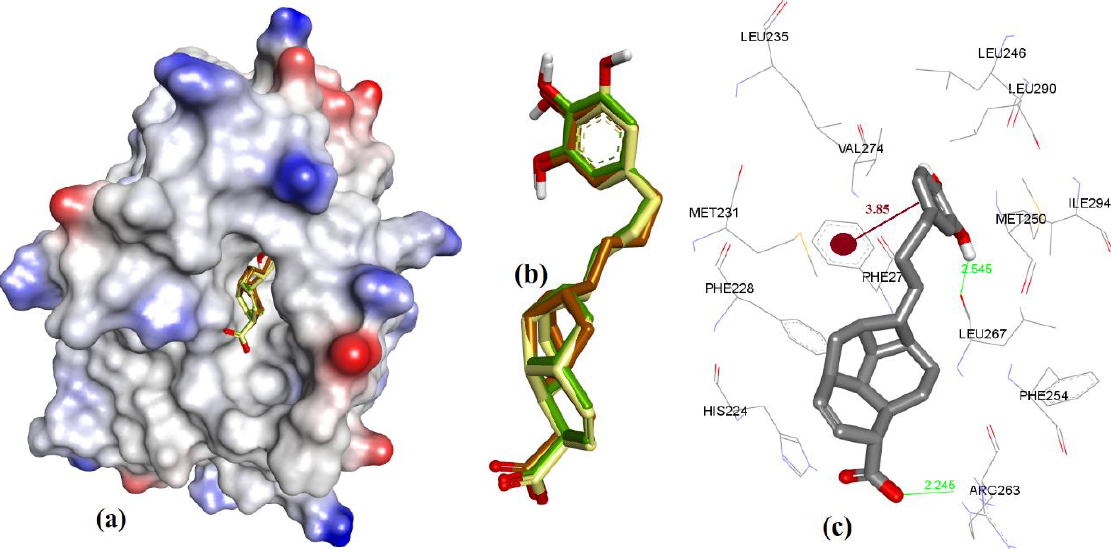
Figure 15. ( a ) The ionized solvent-exposed surface mapping of hMcl-1 along with the docked poses of 4c from MOE (in brown), AutoDock (in green), and VlifeDock (in yellow) show their fitting to the cavity. ( b ) Similar-pose ensemble clustering of all three poses was attained from the three different docking methods. ( c ) Binding mode of 4c .